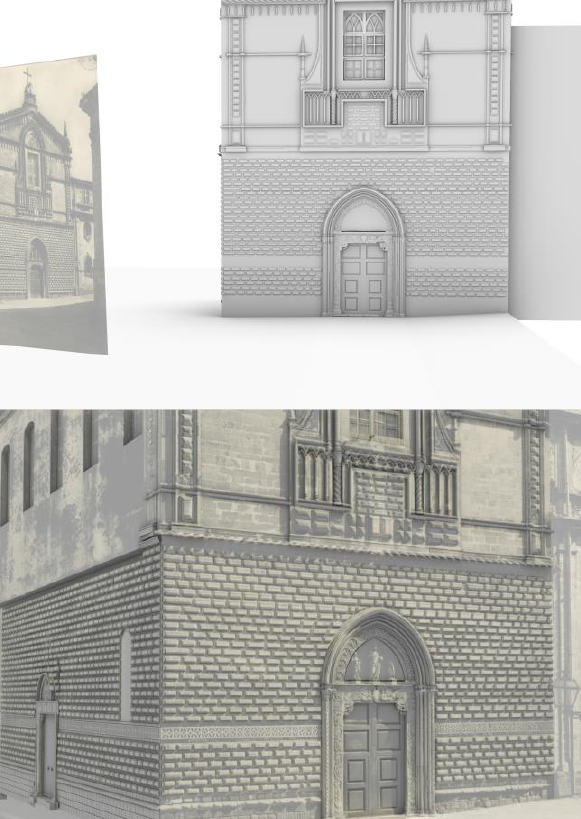
Figure 16 . The portal of the façade of Santa Maria della